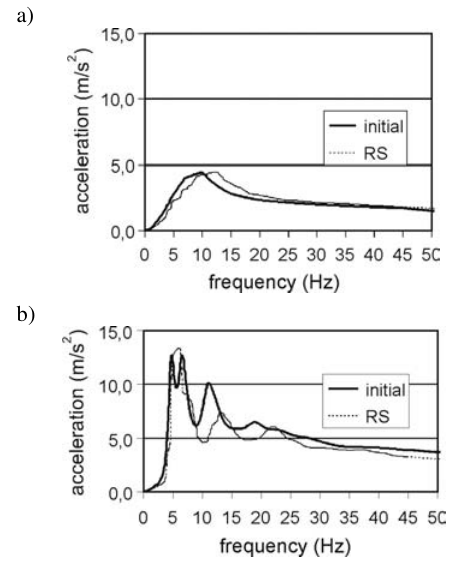
Fig. 13. In-structure horizontal (East-West) acceleration response spectra in selected points at different levels: a – z = 20,0 m; b– z = 36,0 m The distribution of the seismic bending